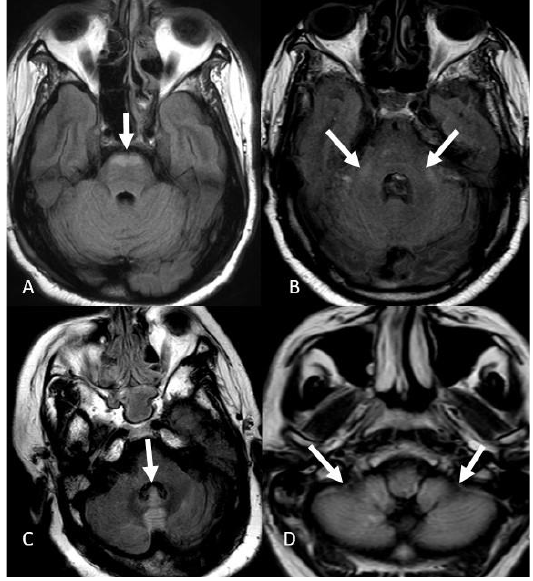
Figure 5. Posterior fossa involvement. ( A ) Axial FLAIR images demonstrate FLAIR hyperintensity in the ventral portion of the pons. ( B ) Bilateral middle cerebellar peduncle FLAIR hyperintensities. ( C ) FLAIR hyperintensity of the vermis. ( D ) FLAIR hyperintensities in the bilateral cerebellar hemispheres. Image has been windowed manually to improve the visibility of signal abnormality.